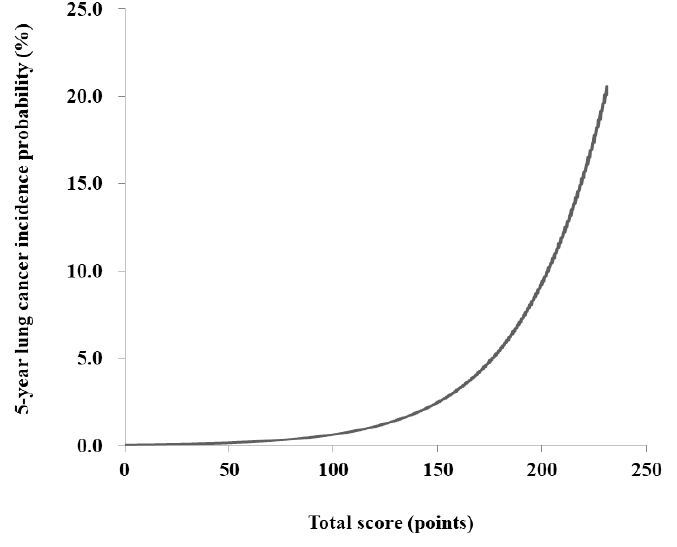
Figure 3. The 5-year incidence probability of lung cancer based on the total score.